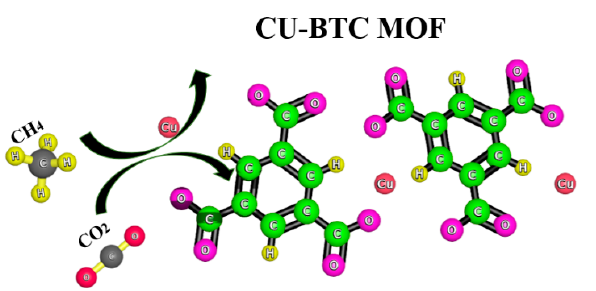
Figure 2. Schematic diagram of selective gas adsorption in Cu-BTC MOF (copper benzene-1,3,5-tricarboxylate) based on molecular sieving effect.